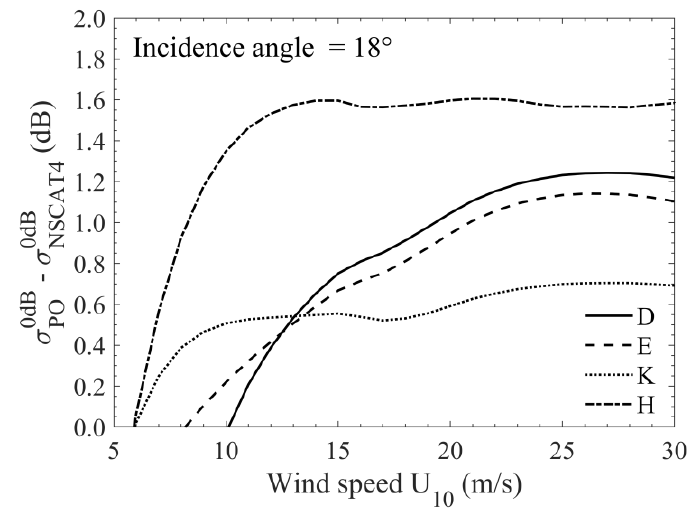
Figure 5. Differences between the omnidirectional PO computations (in dB) and the azimuthally averaged NRCSs (in dB) obtained with NSCAT4 HH GMF as functions of wind speed at an incidence angle of 18°. Curve style sequence for D, E, K, and H spectra is solid, dashed, dotted, and dash-dotted.